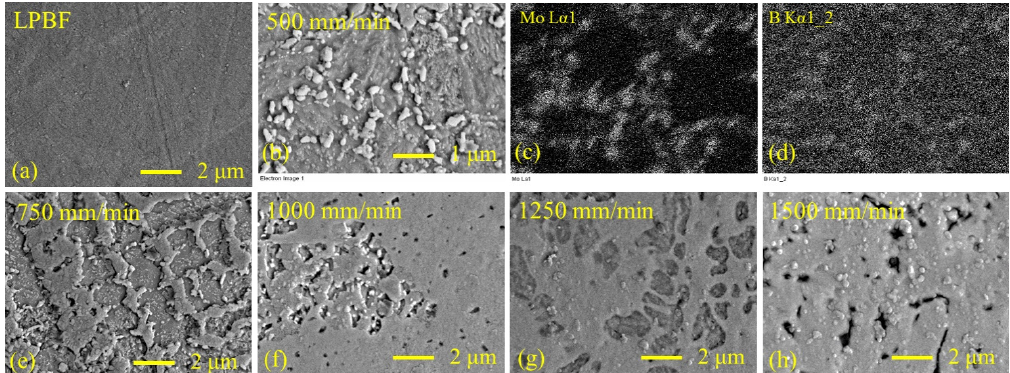
Figure 12. Microstructure of LPBF sample ( a ) and laser-boronized layers ( b , e – h ) after aging; ( c ) and ( d ) distribution maps of molybdenum and boron for the sample laser-boronized at 500 mm/min laser operating speed; ( b ) and ( e – h ) white precipitates rich in molybdenum and boron.